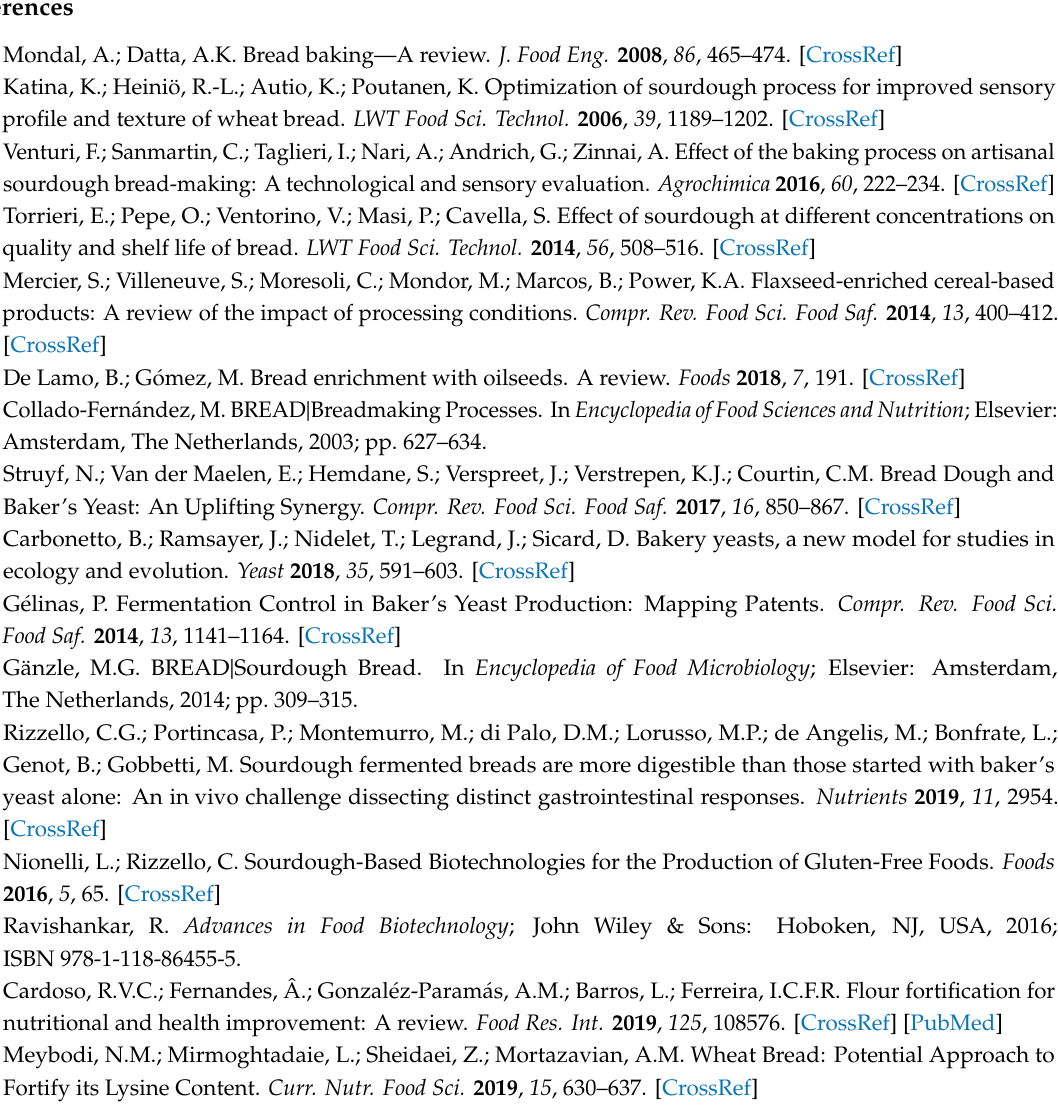
Table S1: Complete headspace compositions of cooked breads (w = whole or s = sliced) as a function of